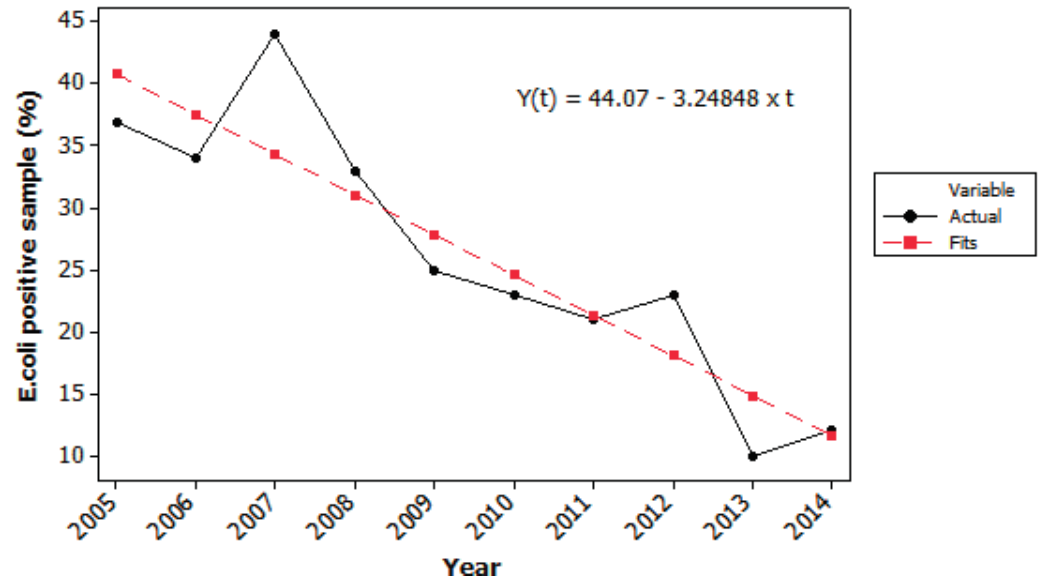
Figure 3. Detection of Escherichia coli in the raw water at Oset water treatment plant by weekly routine samples. The figure shows % of the 52 ± 2 weekly samples where E. coli was detected each year from 2005–2014.